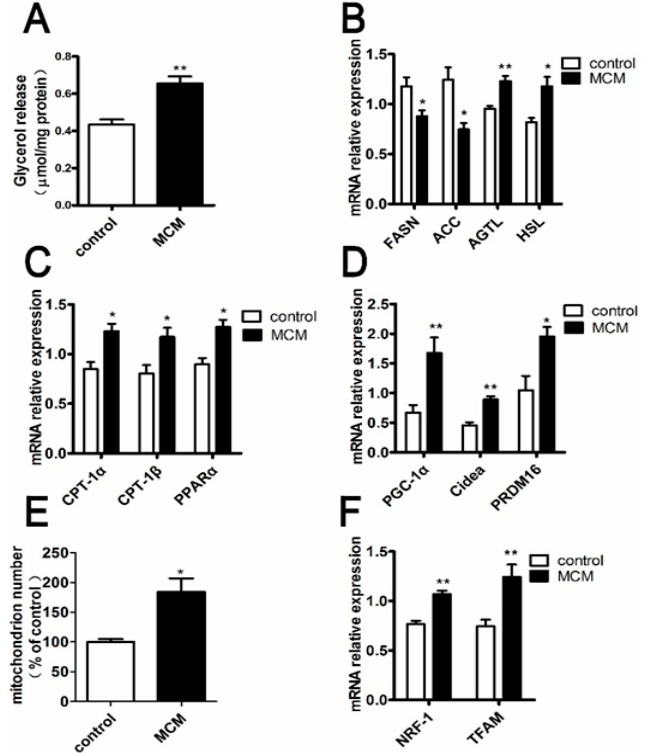
Figure 8. Effect of MCM on adipocyte lipolysis and fatty acid oxidation. Fully differentiated adipocytes were incubated with the Dulbecco’s Modified Eagle’s medium (DMEM) (no phenol red) with MCM for 24 h to verify the lipolytic effects of MCM. The glycerol levels in the culture medium were assayed ( A ); Adipocytes were cultured with MCM for three days. The expression levels of genes involved in lipolysis ( ATGL and HSL ) and fatty acid synthesis ( FASN and ACC ) ( B ) were detected by q PCR, respectively; Relative mRNA expression of genes responsible for fatty acid oxidation ( PPAR α , Cpt-1 α , and Cpt-1 β ) ( C ) and thermogenesis ( PGC-1 α , PRDM16 , and Cidea ) ( D ) was detected; Relative abundance of mitochondrial DNA (mtDNA) ( E ) and the genes responsible for mitochondrial biogenesis ( PGC-1 α , TRFM , and NRF ) ( F ) were detected. Dates were normalized to the mRNA levels of RPLP0 . n = 6, * p < 0.05, ** p < 0.01.